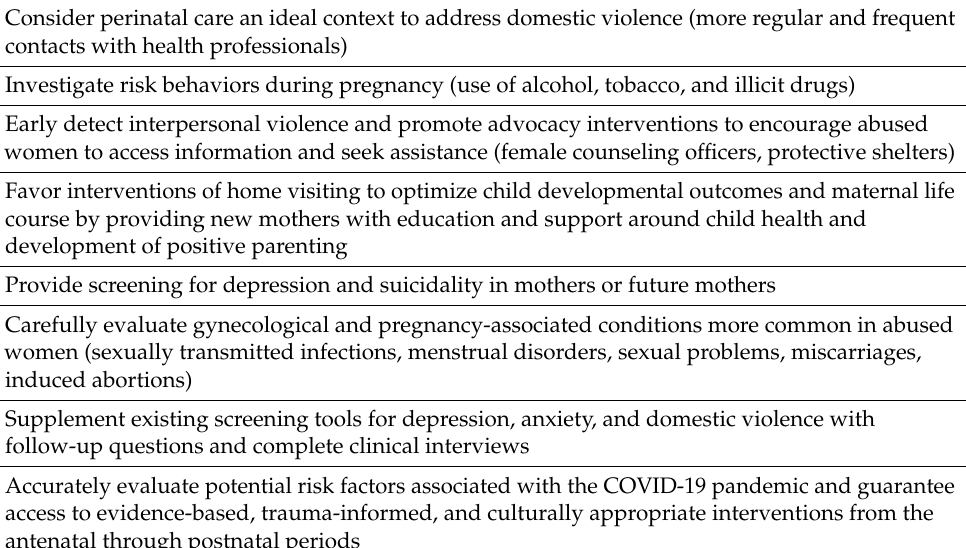
Table 1. Preventive measures to protect victims of interpersonal violence during